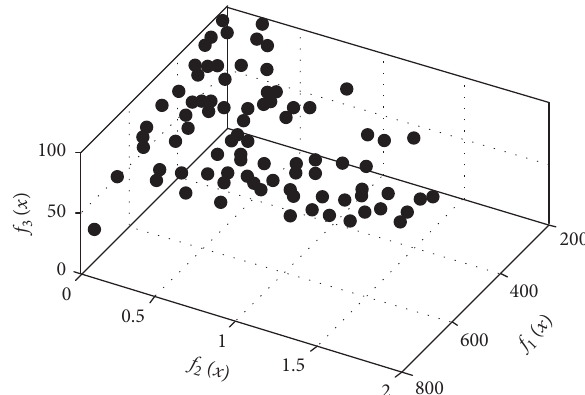
Figure 5: Pareto results of coordination optimization for sec- ondary cooling and electromagnetic stirring (without adaptive grid trimming).